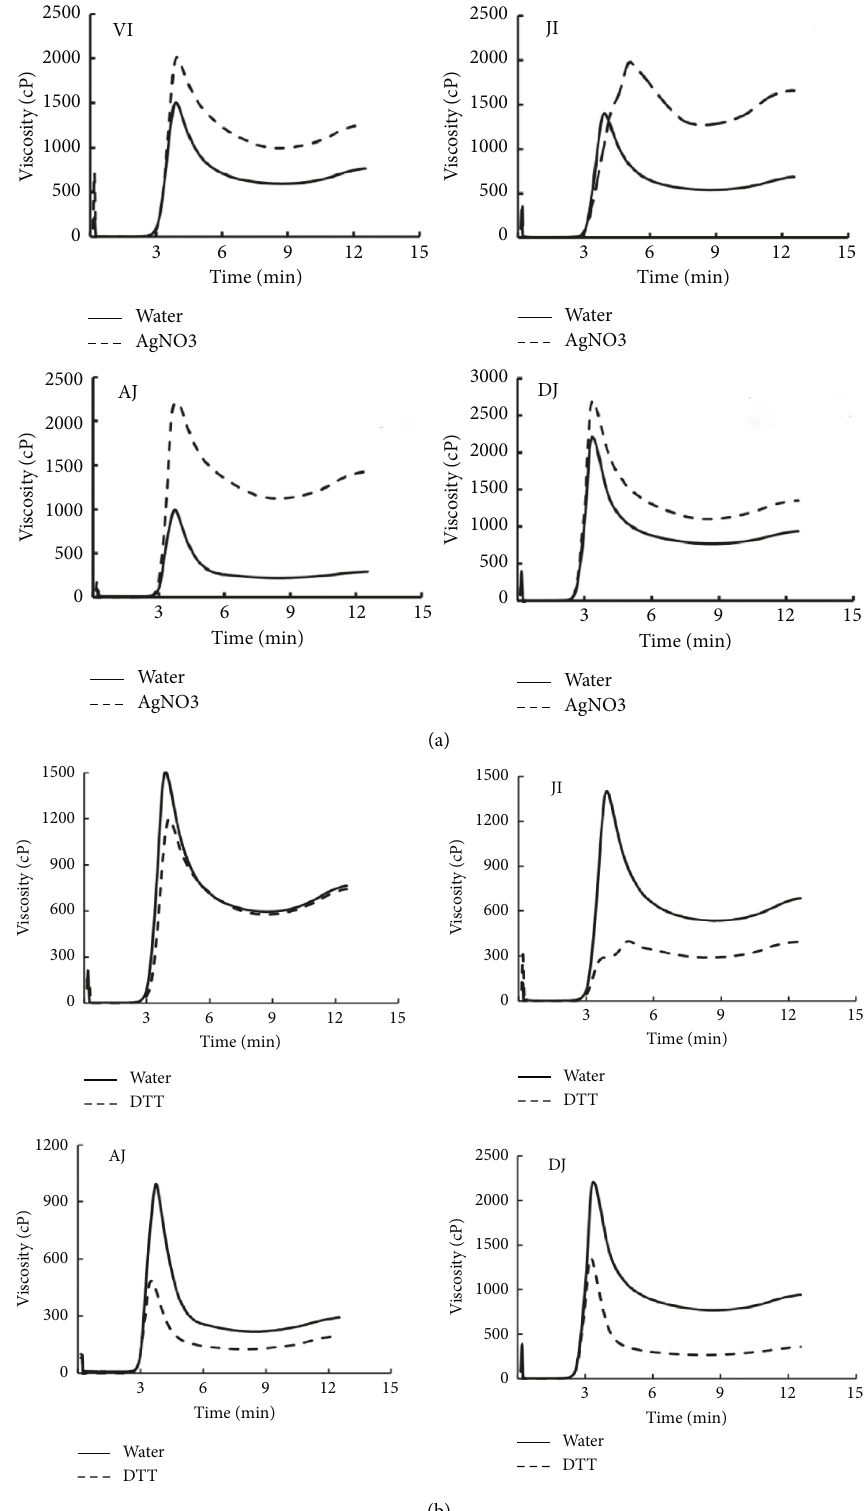
Figure 1: Pasting curves of waxy rice flours treated with (a) distilled water or AgNO Jiangxi indica; AJ: Anhui japonica; DJ: Dongbei